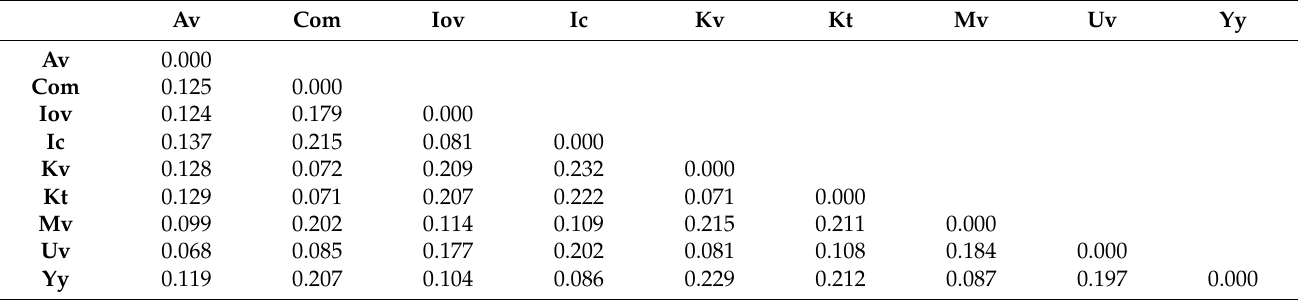
Table 6. Pairwise population matrix of Nei genetic distance for nine groups of bean ( P. vulgaris L.)